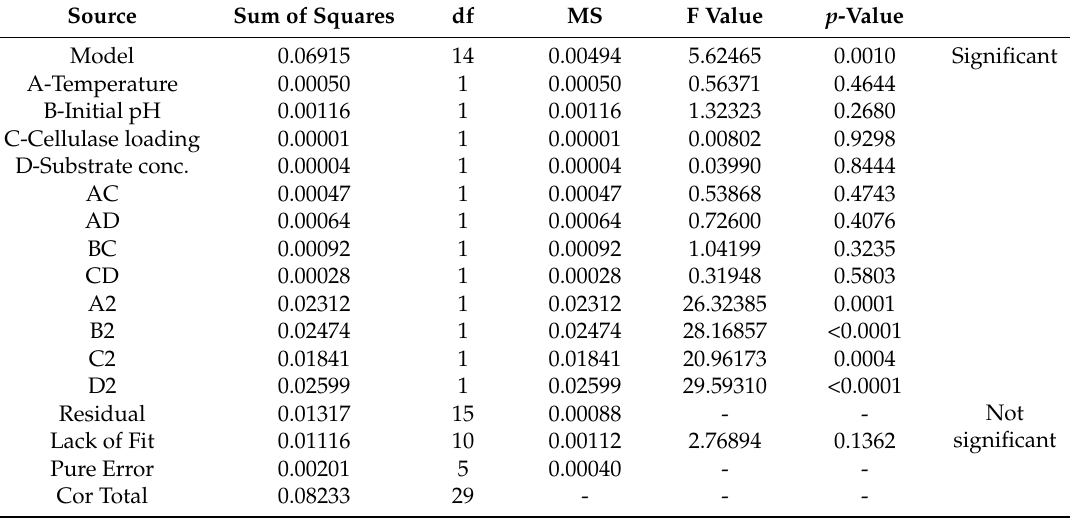
Table 5. The analysis of variance (ANOVA) results for the response of biobutanol